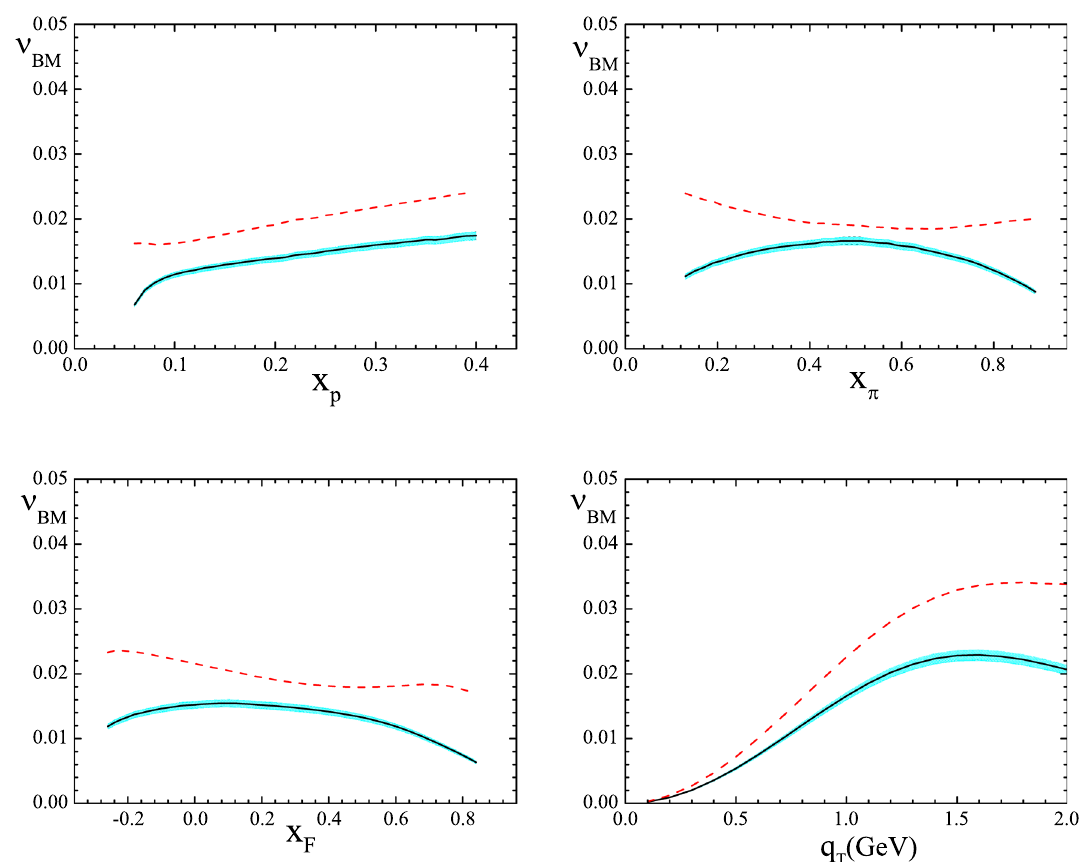
Fig. 3 The asymmetries (solid lines) calculated from the parameterized result for the unpolarized pion PDF f 1 π . The shadow areas correspond to the uncertainty of the parameter A in the model calculation of the pion Boer-Mulders function in Ref. [35]. The dashed lines show the curves in Fig. 2 for